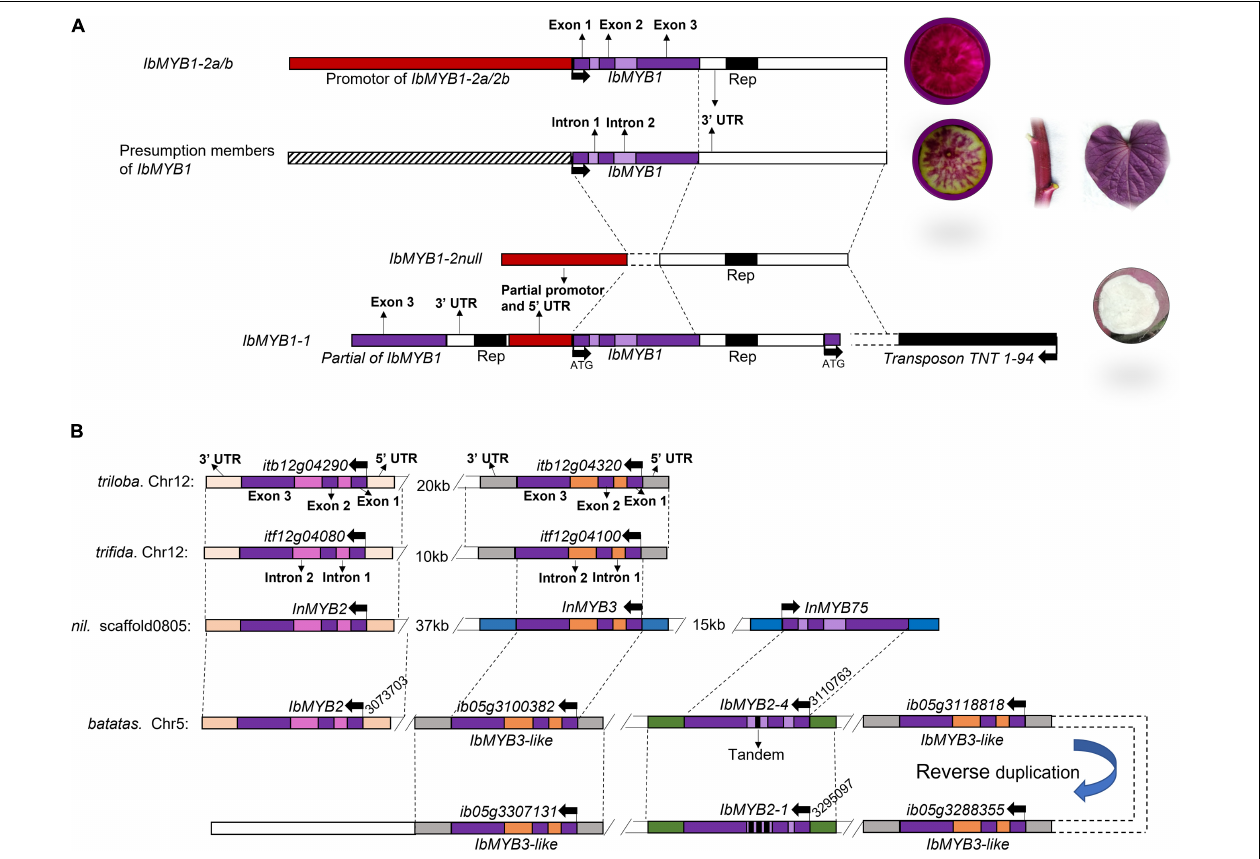
FIGURE 5 | Flanking and coding sequences difference of IbMYB1 and IbMYB2s in sweet potato. (A) Sketch map of IbMYB1 members and their flanking sequence differences. (B) Sketch map of MYB2 homologous locus on the reference genome of Ipomoea triloba , Ipomoea trifida , Ipomoea nil , and Ipomoea batatas . The same color boxes represent highly homologous sequence segments. This model assumes that the members of IbMYB2s are the copy number variants arranged in a tandem array in the haplotype genome. The actual distribution of these genotypes may be parallel, parallel with tandem arrays coexisting in hexaploidy, or even more complex. However, we have not obtained enough genetic data to distinguish these possible arrangements in this